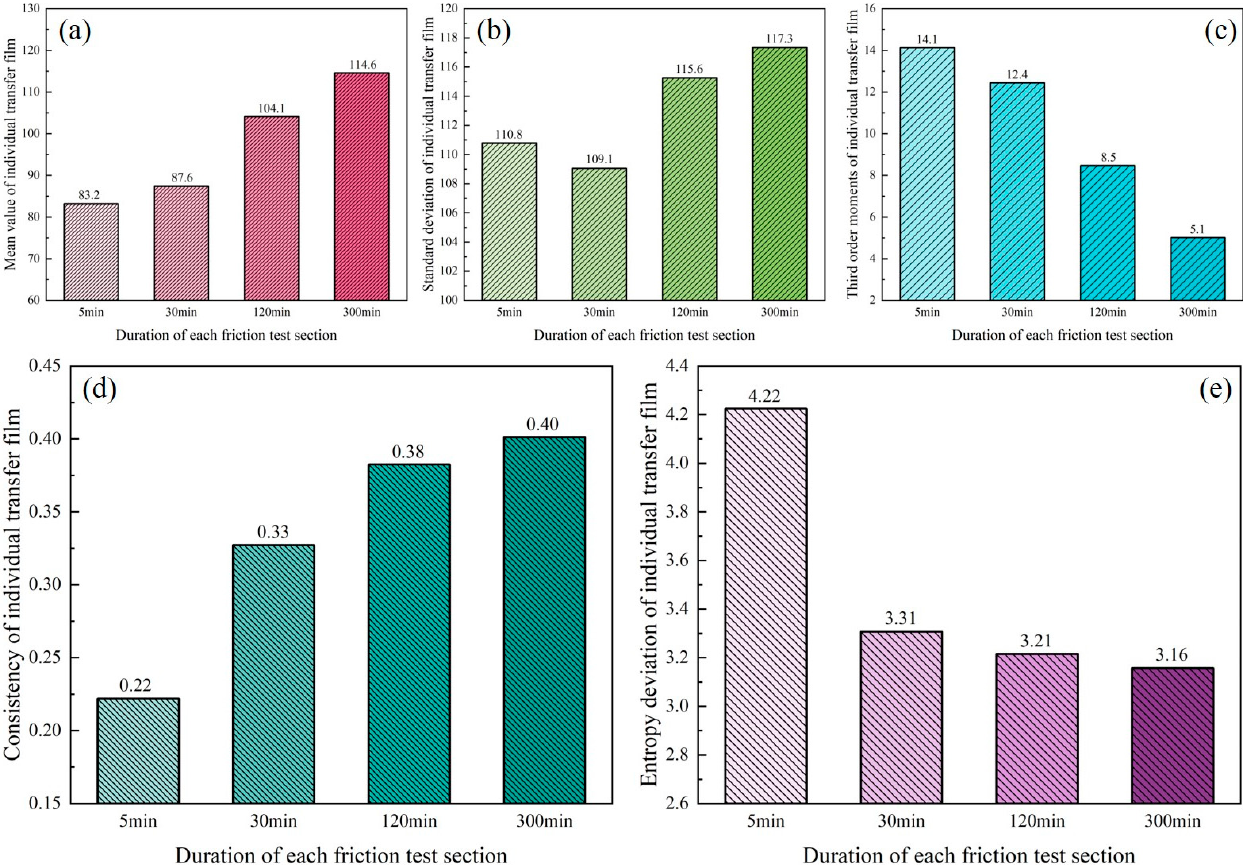
Figure 12. Textural characteristics of the transfer film parameters. ( a ) mean value; ( b ) standard deviation; ( c ) third-order moments; ( d ) consistency; ( e ) texture entropy.